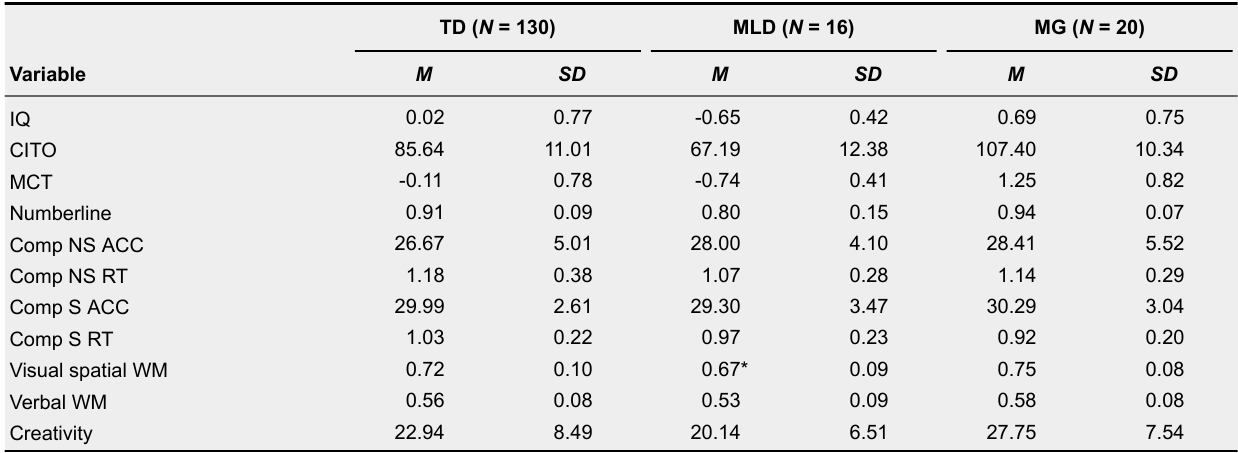
Means and Standard Deviations of the TD, MLD and MG Group